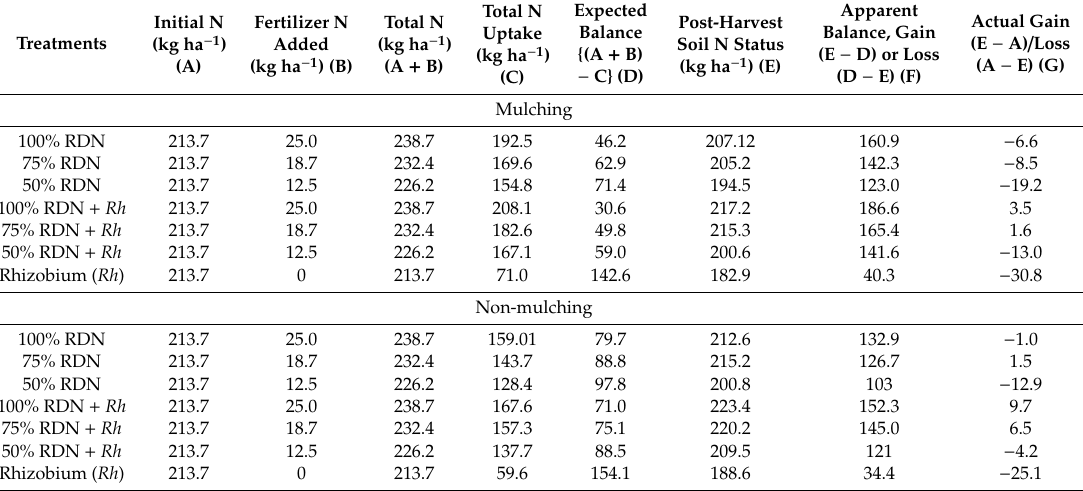
Table 5. Nutrient balance of peanut under di ff erent mulch and nutrient management practices (2016–2017).